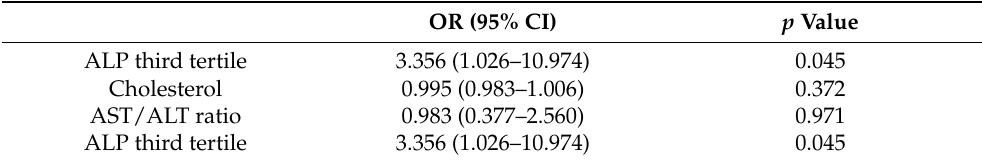
Table 4. Logistic regression analysis of the relationship between ALP and adverse neurologic event or acute infarction.